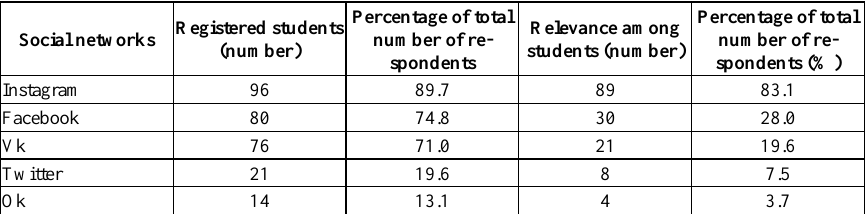
Table 3. Ranking of social networks among students according to their popularity Percentage of total Registered students Social networks number of (number)